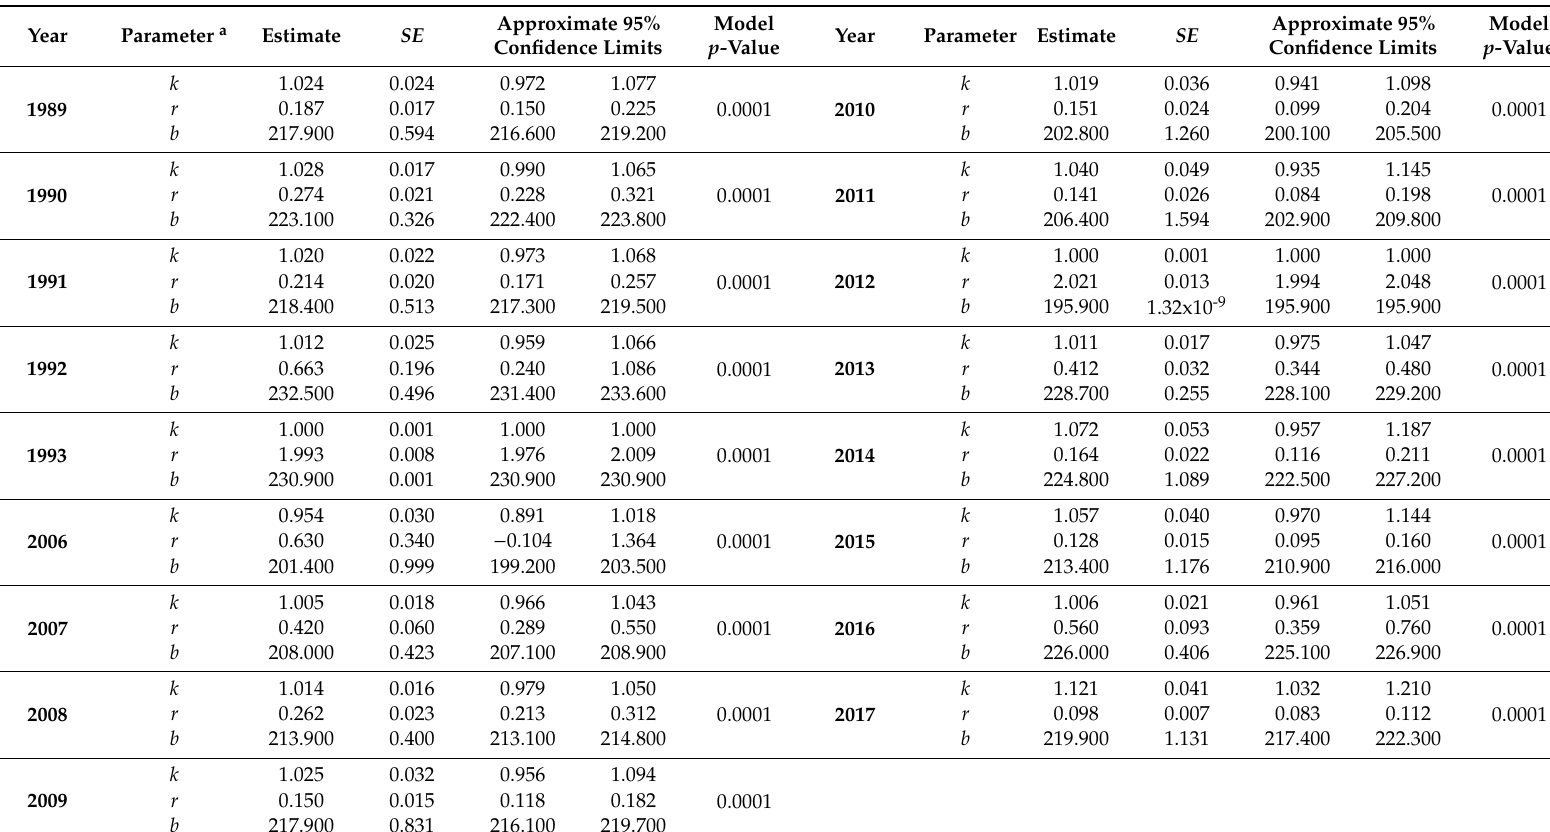
Table 3. Summary of the logistic model (Equation (1)) fitting results for each of the 31 years (1987–2017) with enough ODM